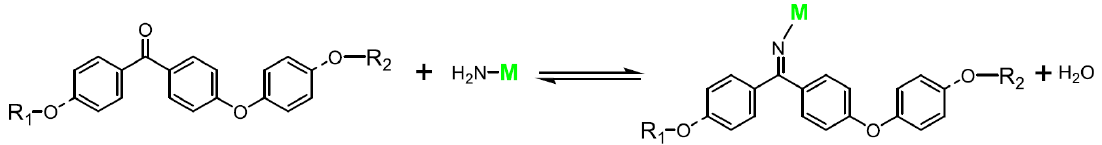
Figure 3. Schema of chemical coupling of a primary amino compound (the modifier M) to